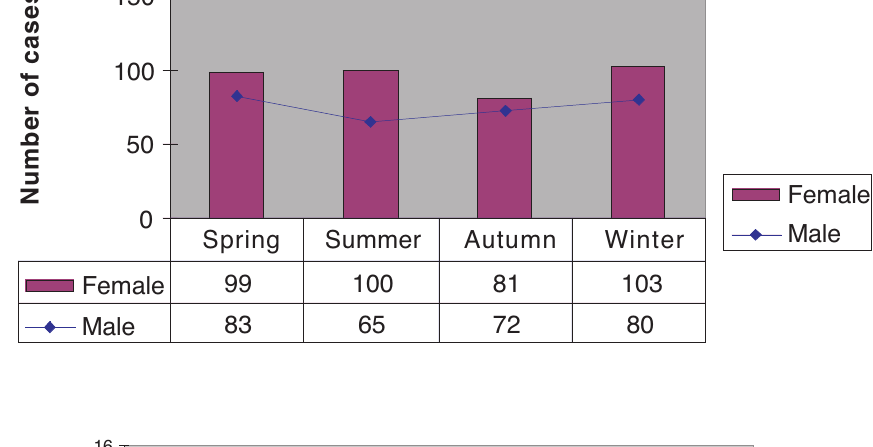
Figure 5 Distribution of aneurysm cases according to the seasons (p = 0.533; p >0.05).